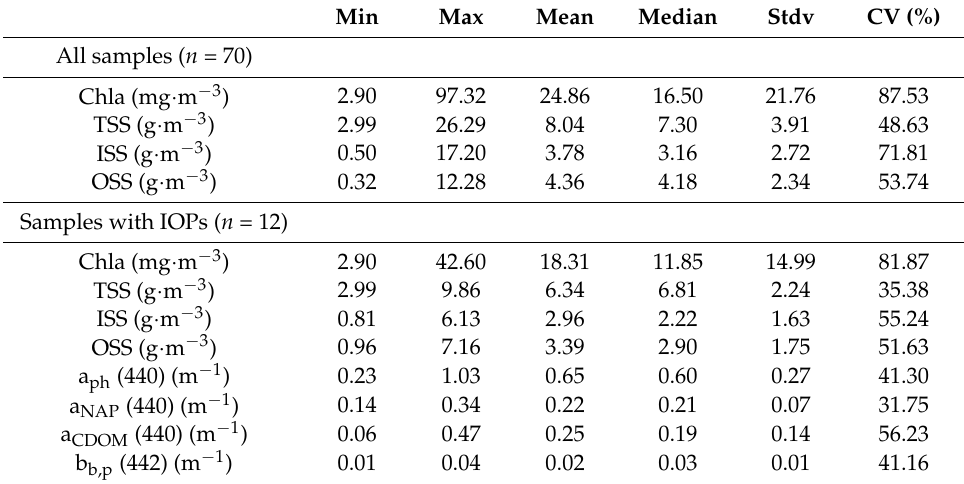
All samples ( n = 70) Table 1. Descriptive statistics of the water quality parameters that were measured in Tokyo